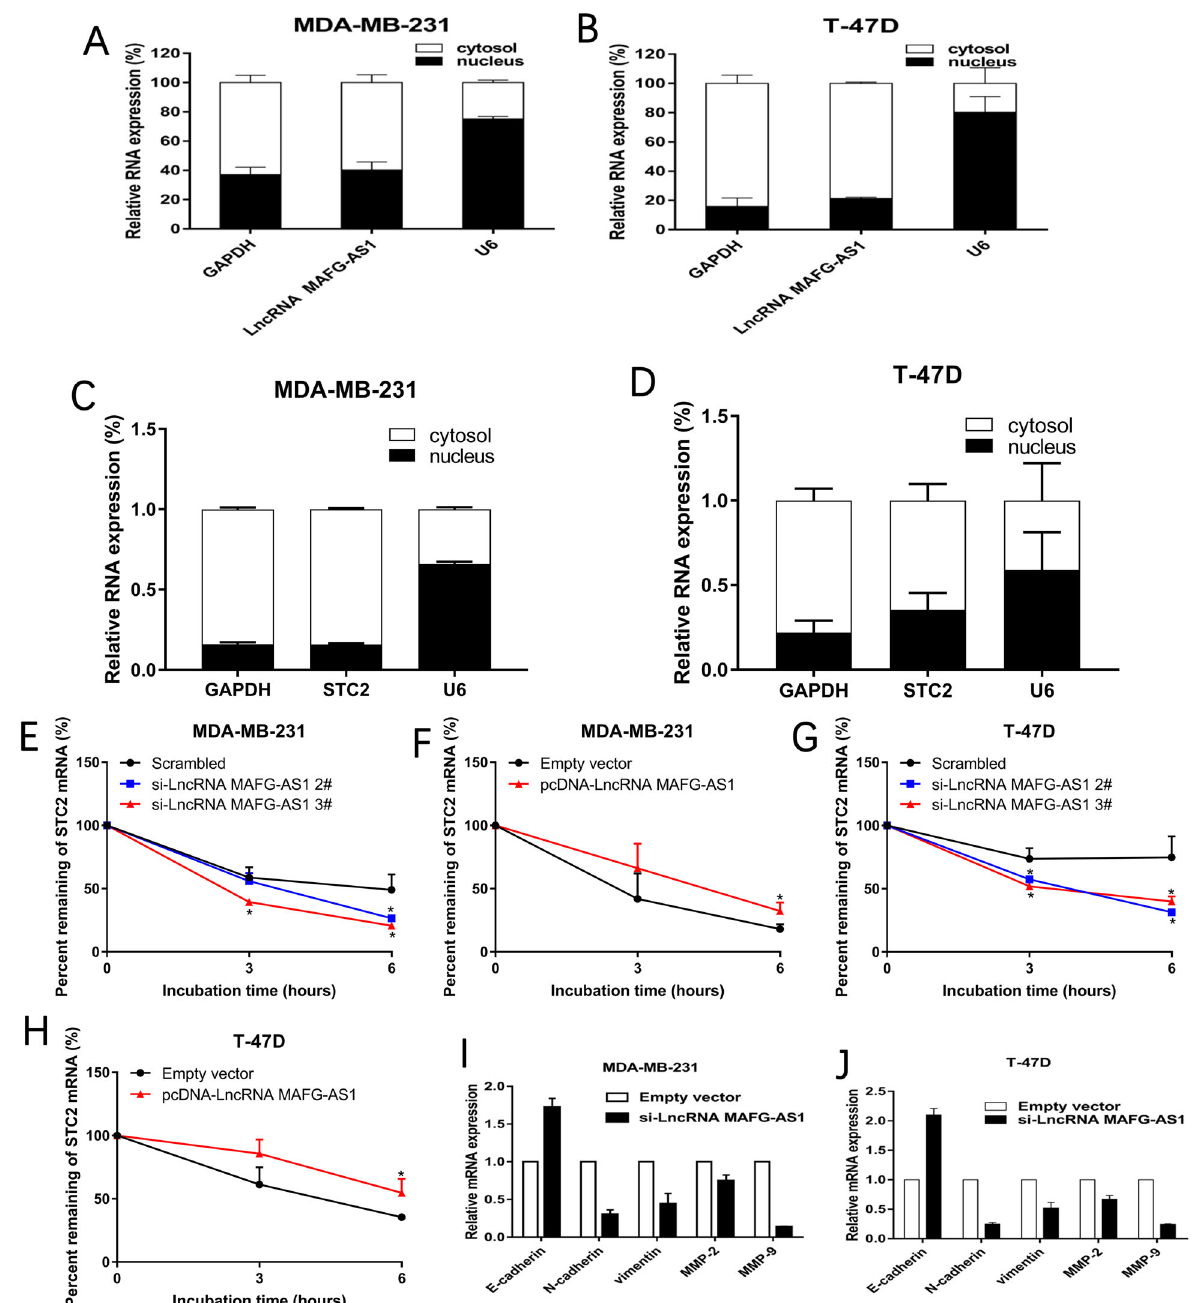
Fig. 9 Prediction of potential mechanisms of oncogenic role of LncRNA MAFG-AS1. A , B LncRNA MAFG-AS1 expression levels in nuclear and cytoplasmic separation of MDA-MB-231 and T-47D cells were detected by qRT-PCR. GAPDH was used as cytoplasm control and U6 was used as nucleus control. C , D) STC2 mRNA expression levels in nuclear and cytoplasmic separation of MDA-MB-231 and T-47D cells were detected by qRT-PCR. GAPDH was used as cytoplasm control and U6 was used as nucleus control. E – H LncRNA MAFG-AS1 controled STC2 mRNA stability. RNA stability assays were performed in MDA-MB-231 and T-47D cells using Actinomycin D to disrupt RNA synthesis, and the degradation rates of the STC2 mRNA were measured over 6 h. I , J) Analysis of E-cadherin, N-cadherin, Vimentin, MMP-2, MMP-9 expression in MDA-MB-231 and T-47D cells treated with si-LncRNA MAFG-AS1. Values are shown as the mean ± s.d in three independent experiments. * P < 0.05, ** P <